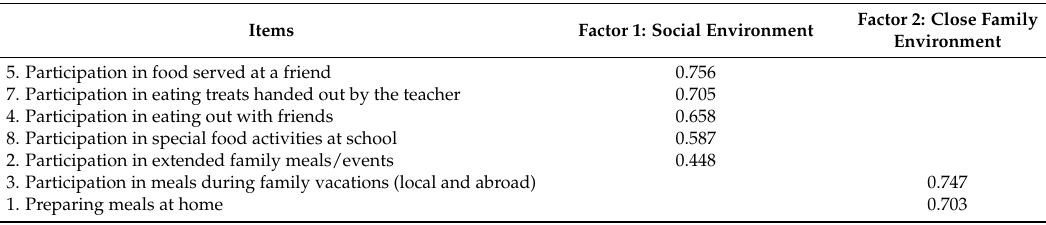
Table 1. Exploratory factor analysis of the